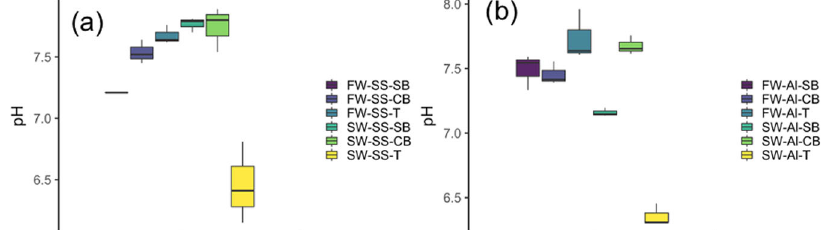
Fig. 8 Shifts in pH following treatment. pH values of experiments with FW and SW with two different electrode compositions i.e., SS and Al. a Depicts the FW and SW samples treated with stainless steel electrodes. b Depicts the FW and SW samples treated with aluminum electrodes. The box and whisker plots denote the median value (line within each box), upper and lower quartiles (top and bottom of box), and minimum and maximum values